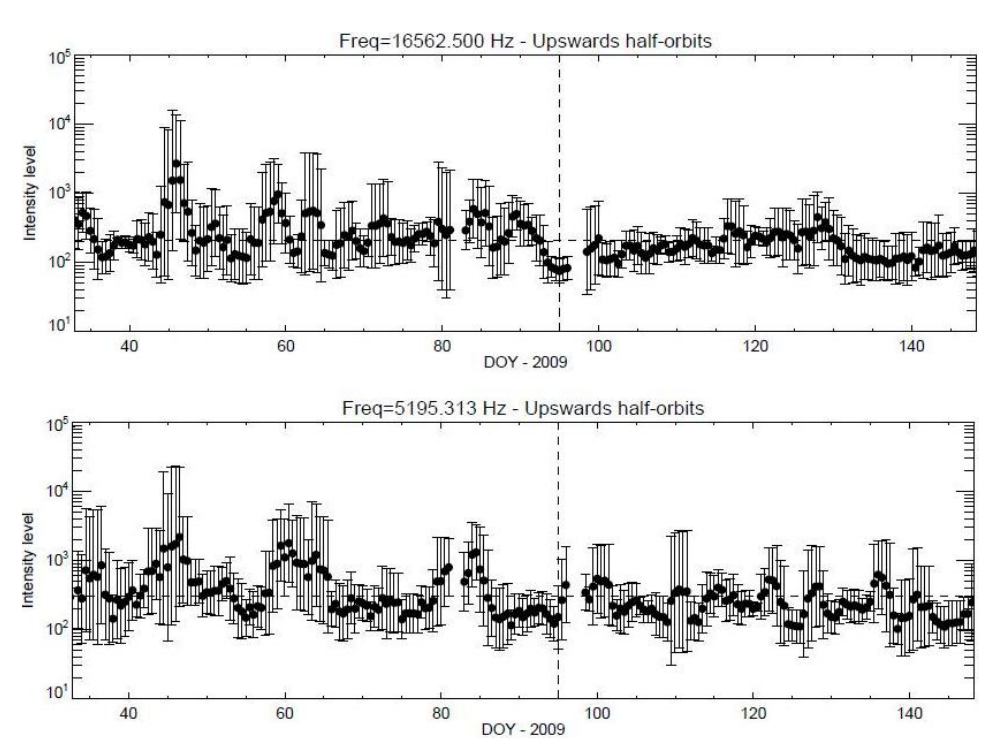
Fig. 4. Variation of the averaged VLF intensity level versus the day of the year 2009 (from 1 February to 28 May). The vertical and horizontal dashed lines indicate respectively the day of EQ occurrence and the mean VLF intensity (over the investigated period of about